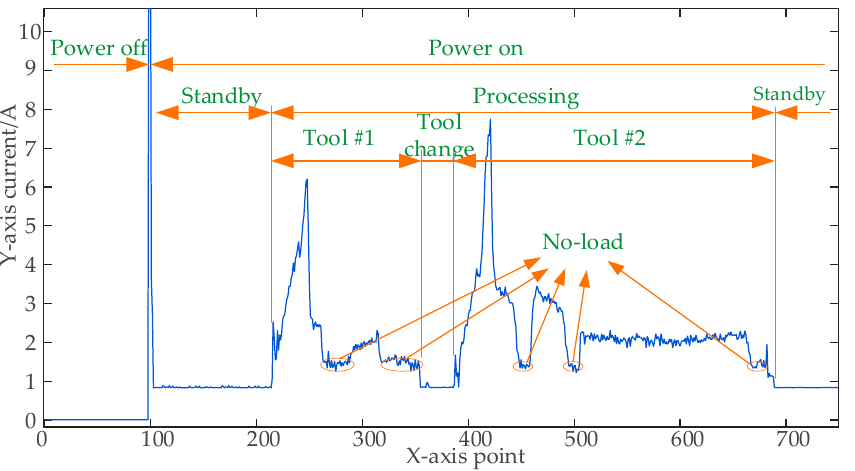
Figure 2. Current variation in a lathe under different operational